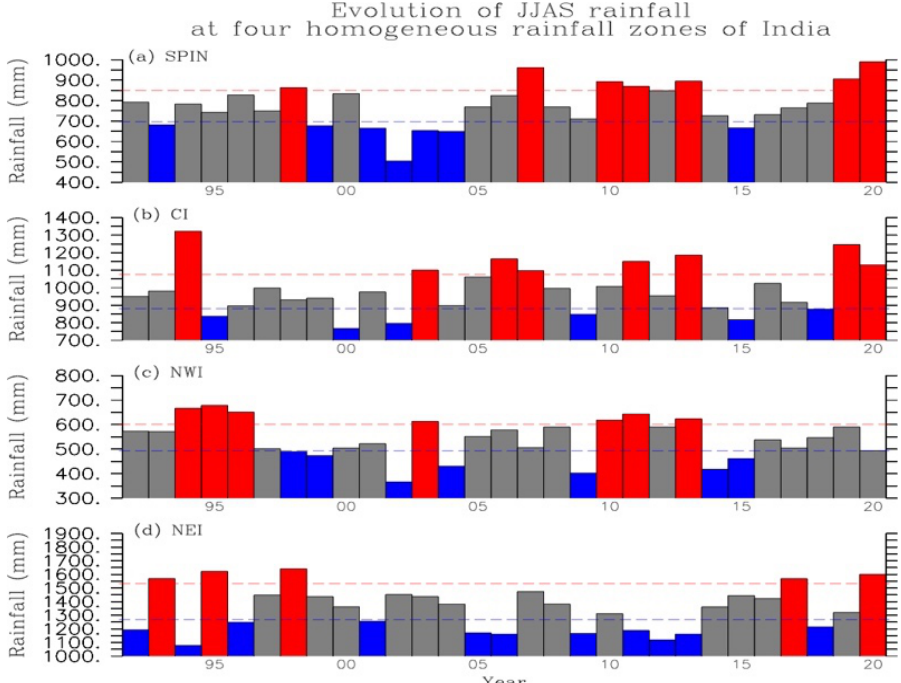
Figure 2. Evolution of JJAS Indian rainfall (in mm) over ( a ) SPIN, ( b ) CI, ( c ) NWI, and ( d ) NEI for the period 1992–2020 derived from the daily 0.25° gridded rainfall product provided by IMD. Strong (red bars), weak (blue bars), and normal (gray bars) ISMs are identified by the departure of JJAS rainfall of each year from the JJAS rainfall climatology computed over each IMD region for the period 1951–2020, whose departure values are larger than +10%, smaller than − 10%, and within − 10% and +10% of the seasonal climatology, respectively. The red (blue) dashed line denotes a value of 110% (90%) of seasonal climatology (i.e., the JJAS rainfall climatology for SPIN, CI, NWI, and NEI are 776.4, 979.3, 545.5, and 1397 mm, respectively). Table 1. A list of years with strong, weak, and normal rainfall over SPIN, CI, NWI, and NEI for the period 1992–2020. The method to define the strength of JJAS rainfall over the IMD regions is de- scribed in Section 2.2.